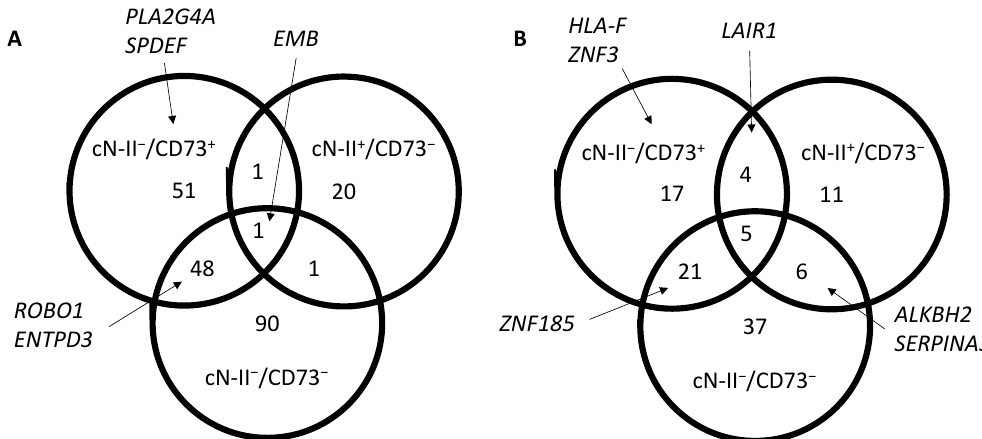
Figure 1. Venn diagrams showing the number of transcripts with at least a 5-fold higher ( A ) or lower ( B ) expression than in cN-II + /CD73 + cells, and with a p -value lower than 0.05. Only transcripts that were positive (FPKm > 1) in at least one model were included in the analysis. Complete list of transcripts is available in Supplementary Table S2.